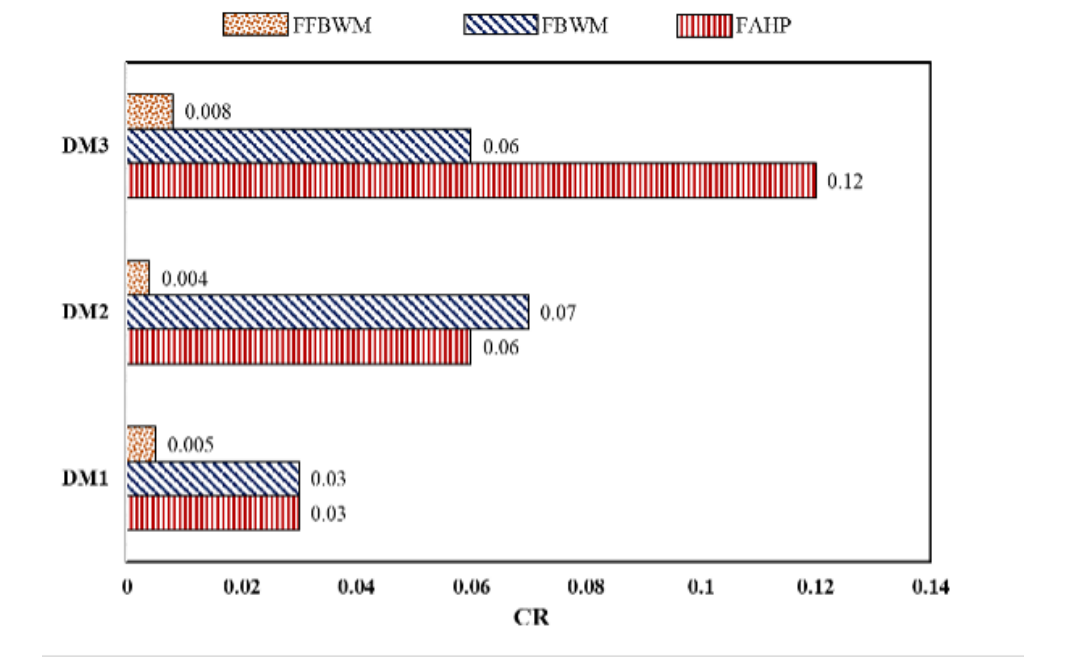
Figure 3. Comparison of CR factors for the three mentioned methodologies.